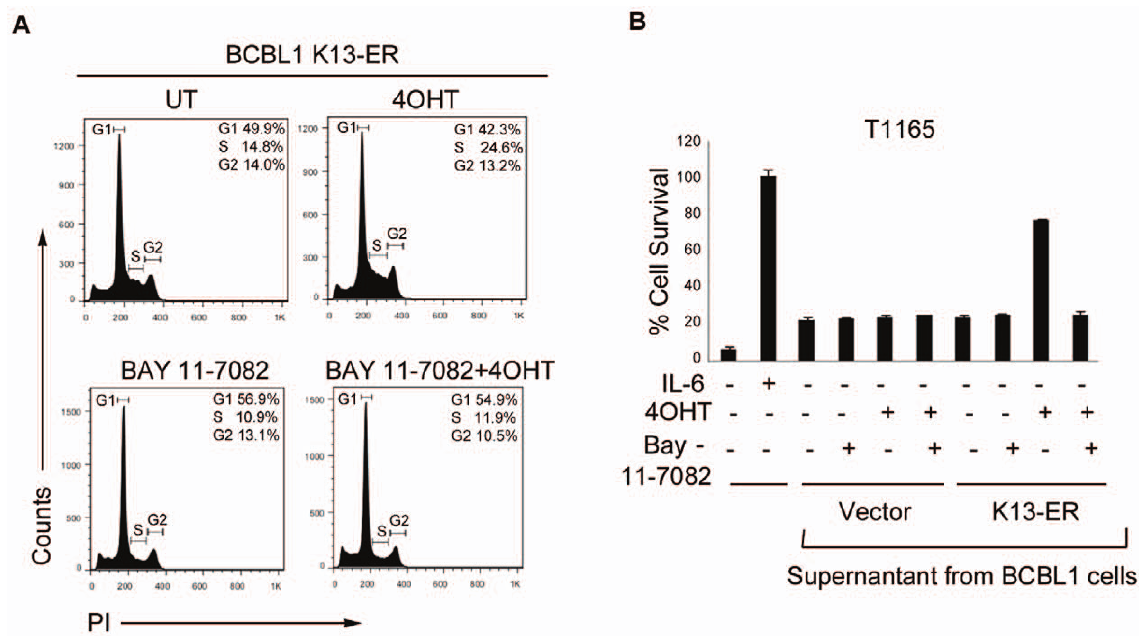
Figure 5. Biological assays to study K13-induced IL6 production and cell cycle analyses. (A) A DNA content analysis showing significant increase in S-phase of cell cycle by 4OHT treatment in serum-starved BCBL1 K13-ER TAM cells and inhibition of this increase in S-phase cells by pre- treatment with Bay-11-7082 (2 m M). DNA content analysis was performed as described previously [7] and explained in Materials and Method section. (B) Cell survival of T1165 cells with supernatants from 4OHT-treated BCBL1-K13-ER TAM cells. BCBL1 vector- and K13-ER TAM cells were pretreated with 2 m M Bay-11-7082 for 2 hours followed by treatment with 4OHT for additional 72 hours and supernatants from these cells were collected and filtered. T1165 cells were treated in triplicate in a 96 well plate (100 m l/well) with 20 m l of cell-free supernatant collected from cells described above. Seventy- two hours post-treatment, cell viability of T1165 cells was measured by MTS assay as described in Materials and Method section. The values (Mean 6 SEM) shown are from a representative of three independent experiments performed in